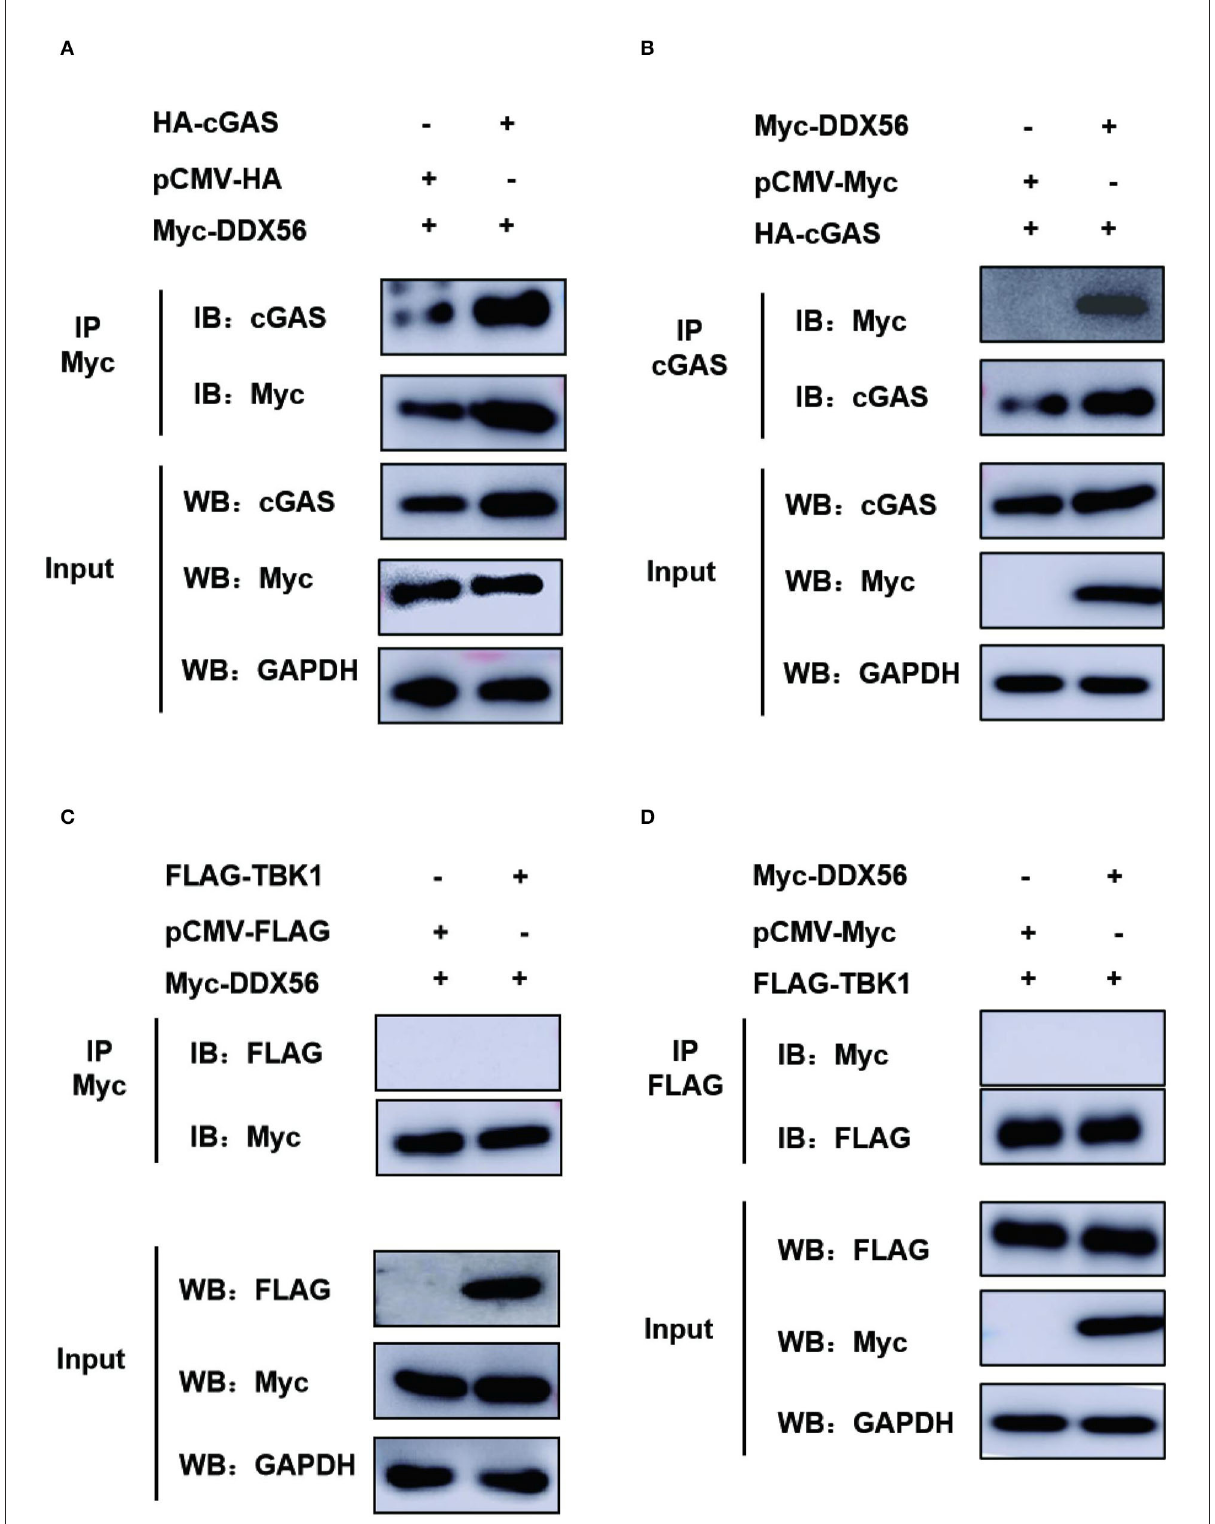
FIGURE6 There is a direct interaction between DDX56 and cGAS. (A,B) The interaction between DDX56 and cGAS was confirmed by a co-immunoprecipitation assay. In PK15 cells, empty vector (EV, 1 µ g) or pCMV-Myc-DDX56 (1 µ g) plasmids and the indicated